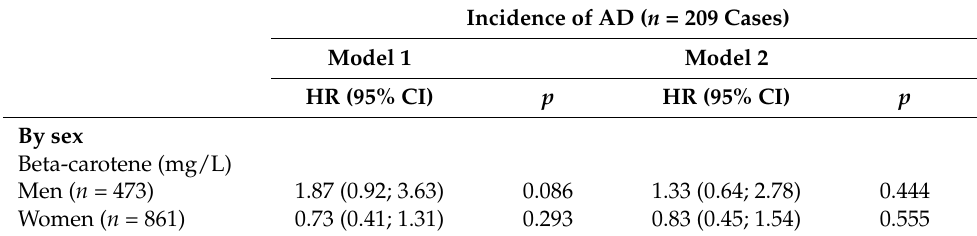
Table 5. Analyses stratified by sex ( n =